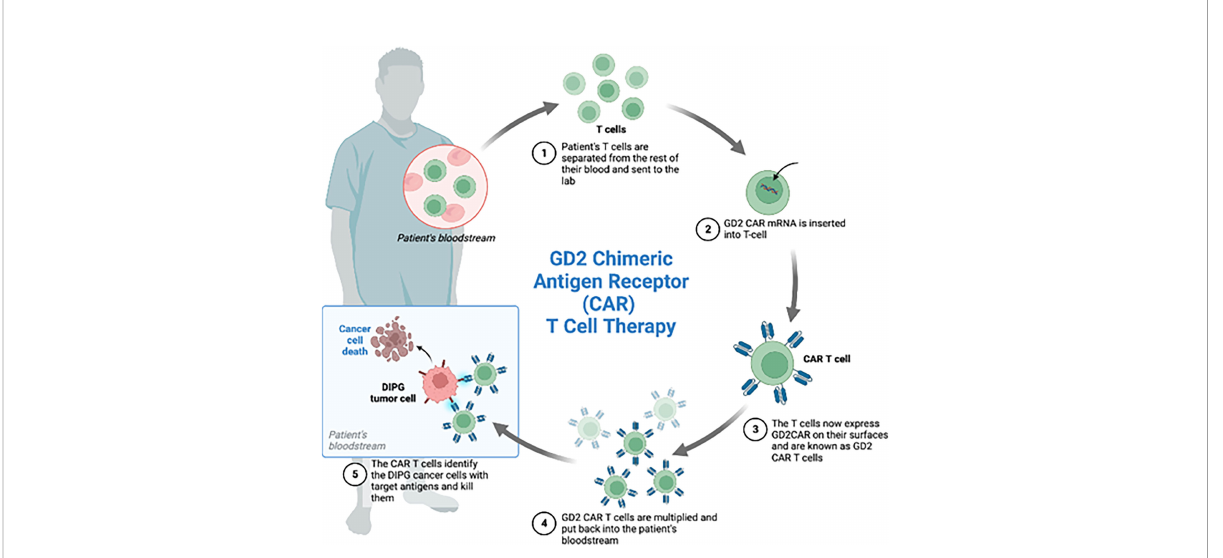
FIGURE 4 Four patients with the diagnosis of diffuse intrinsic pontine glioma were enrolled in the phase 1 clinical trial of GD2-CAR T cells. Each patient received GD2 CAR T cells. These CAR T cells were generated by isolating the patient ’ s T-cells from the rest of the blood, inserting GD2 CAR mRNA and administering the GD2 CAR T cells back to the patients. Expansion of CAR T cells, increased in fl ammation after treatment and increased CAR T cells in the CSF during peak in fl ammation was